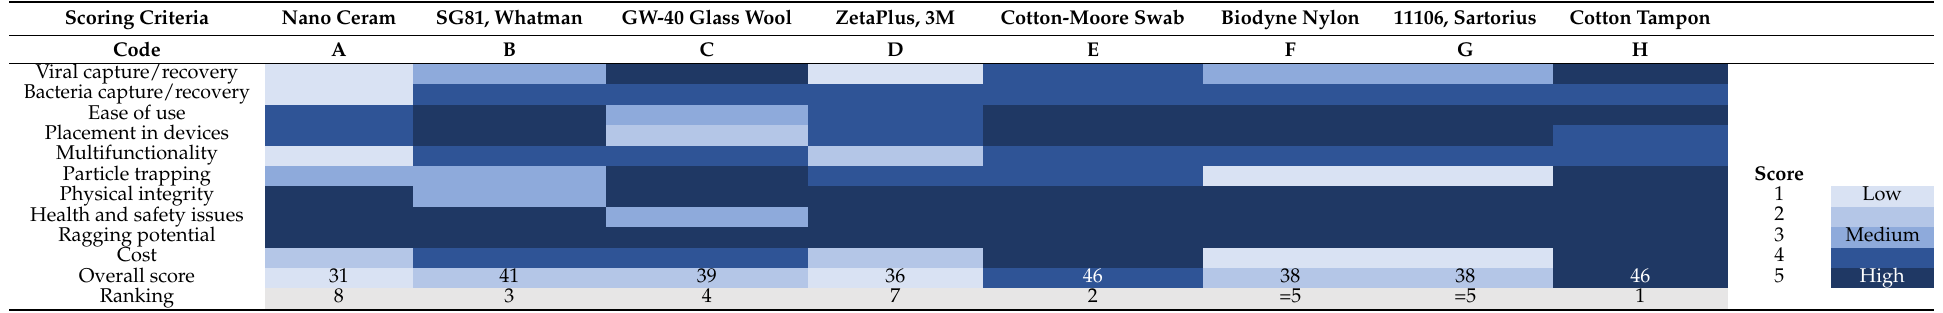
Table 5. Summary of the overall performance and ranking of the eight different passive sampler materials when deployed in a wastewater